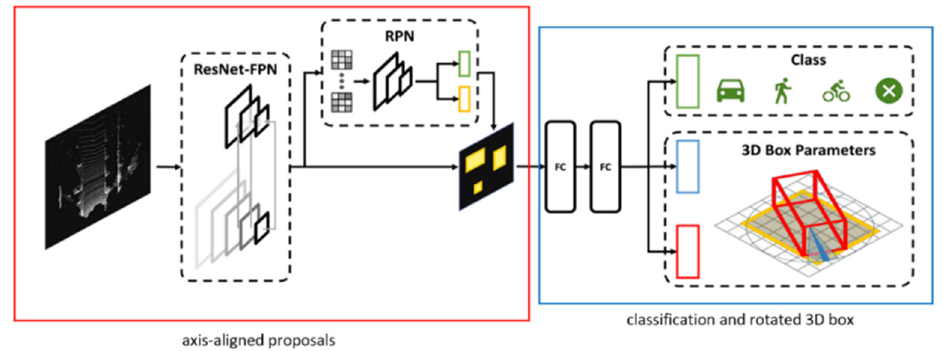
Figure 4. Overview of the BirdNet+.